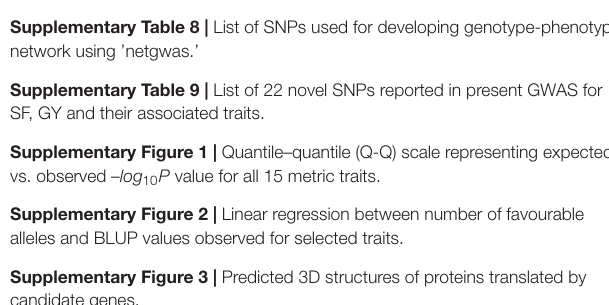
Supplementary Table 7 | Functional annotation of candidate genes.